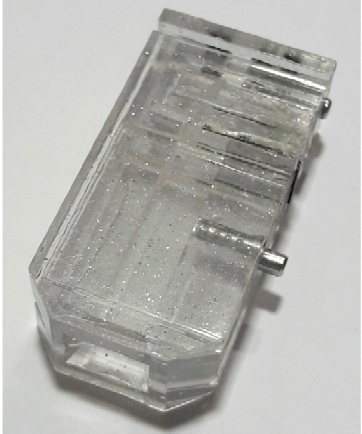
Figure 10. Reflective particles tag on a COBRA seal.